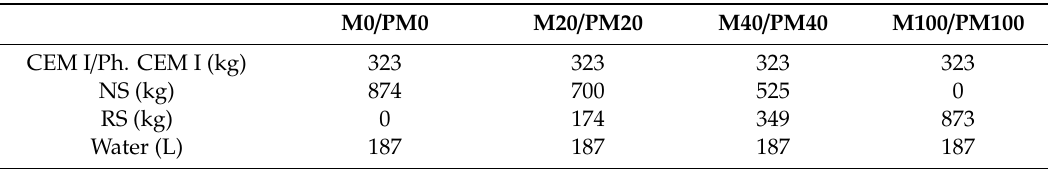
Table 3. Mortar dosage (per m 3